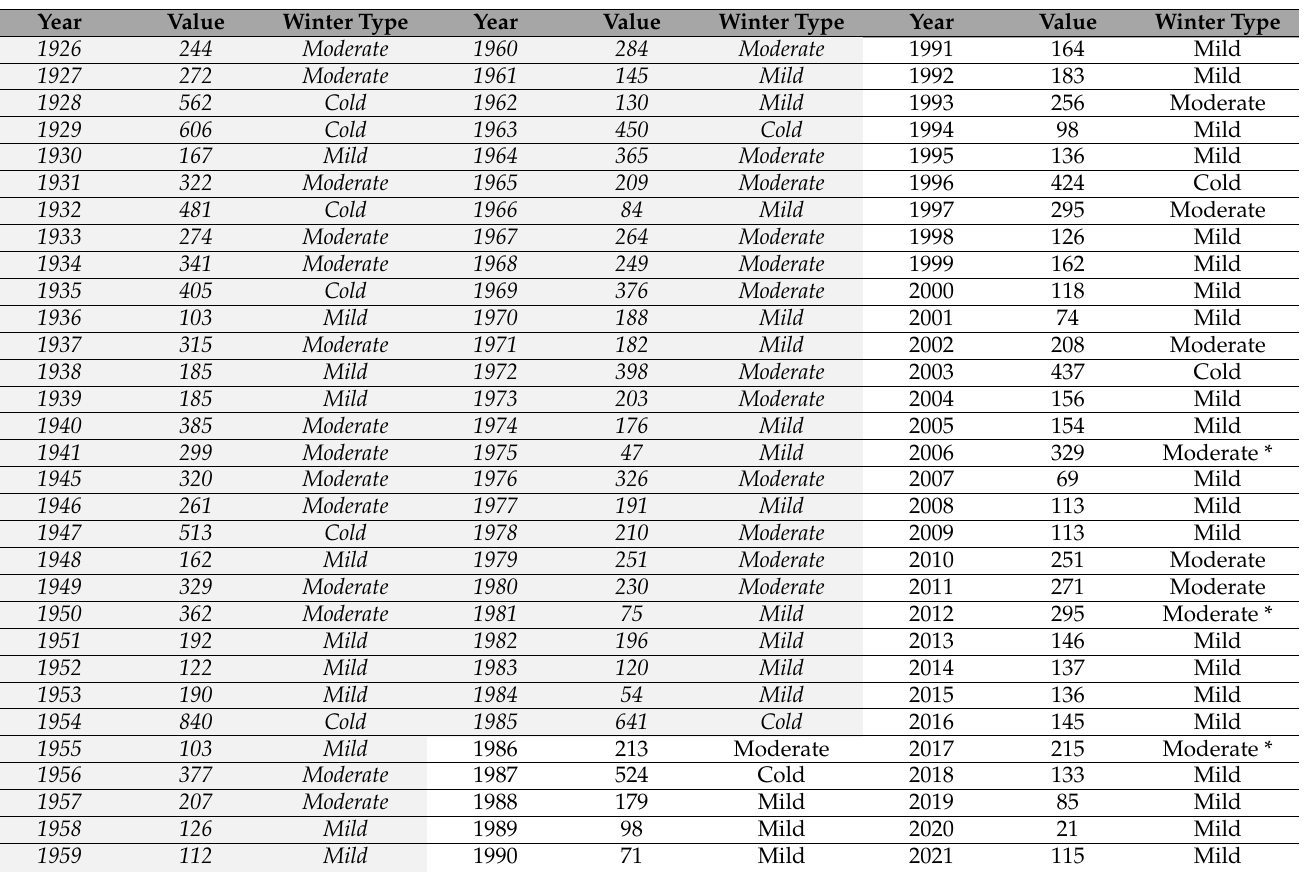
Table 4. Winter type from 1926 to 2021 according to the of WSI value in Table 3. The grey cells in italic font contain Simonov and Altman’s [1]